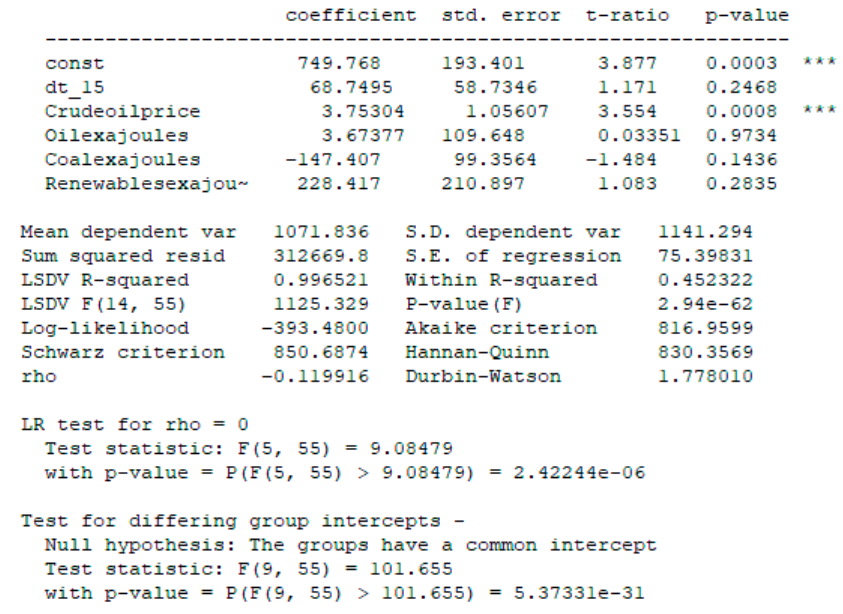
Figure 12. Model with Fixed E ff ects.